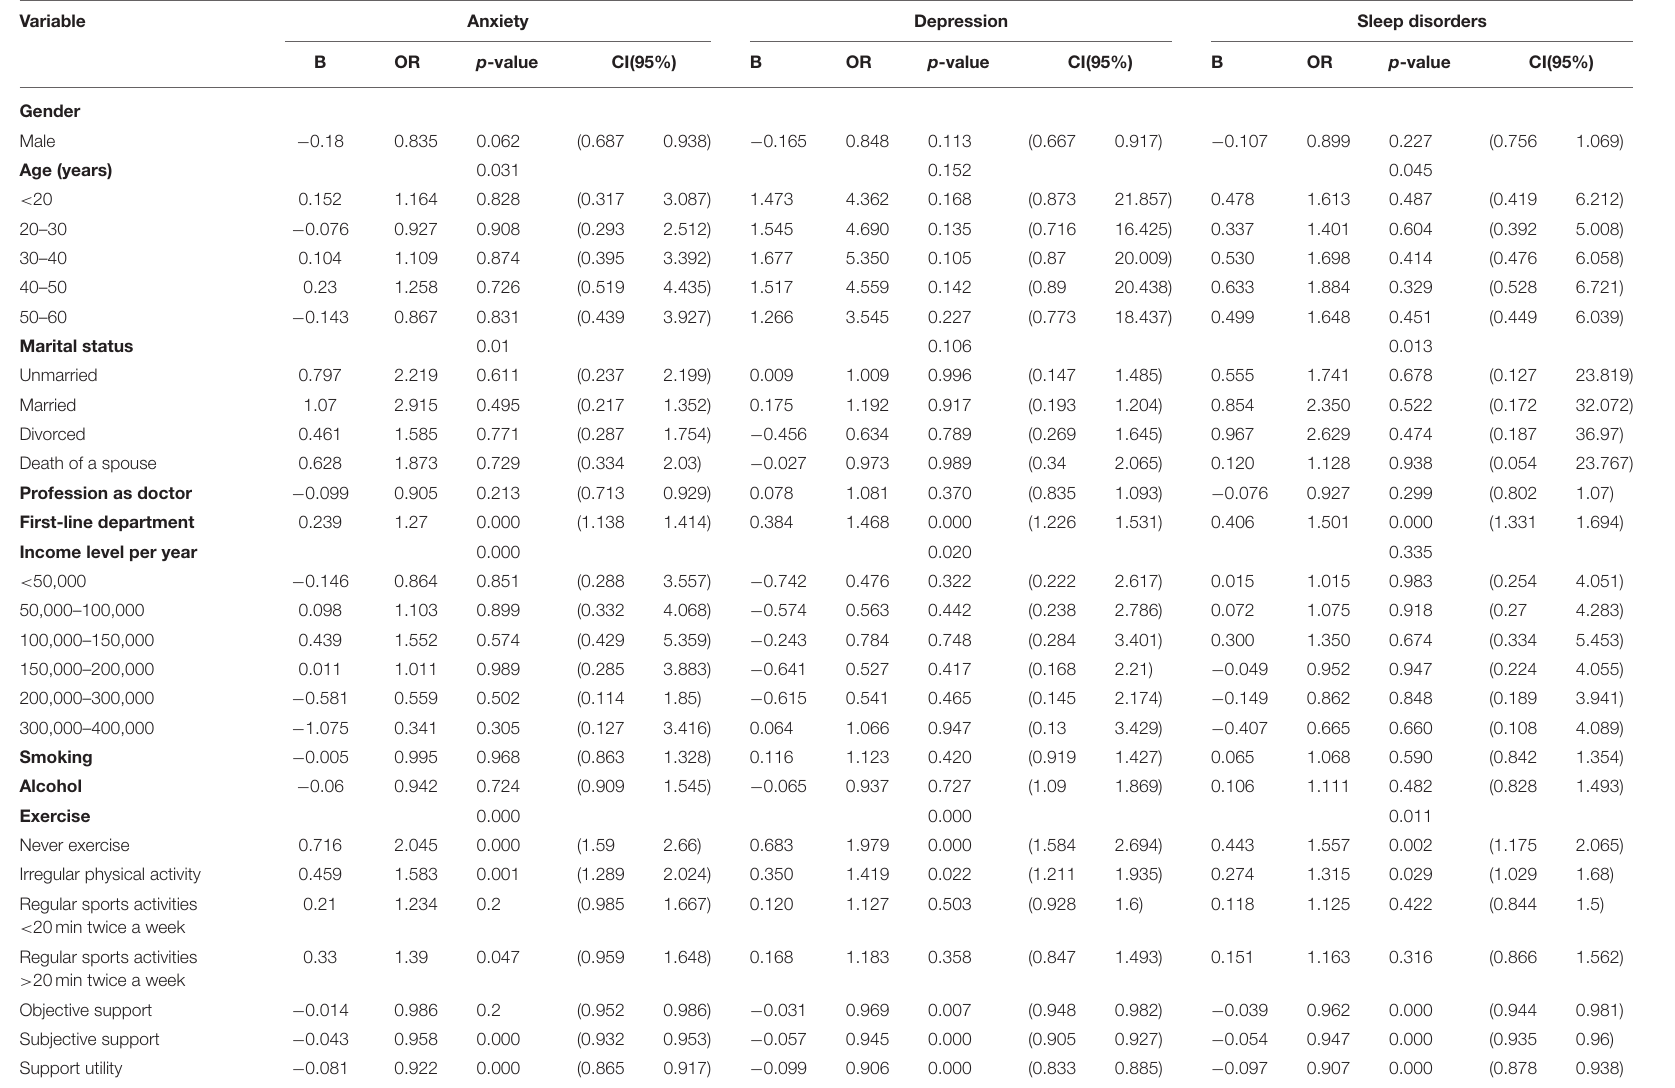
TABLE 3 | Binary logistic regression analysis of